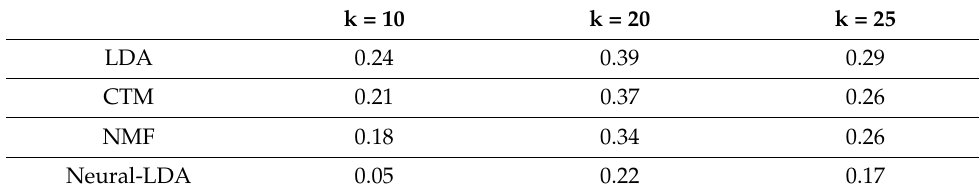
Table 7. Classification results.